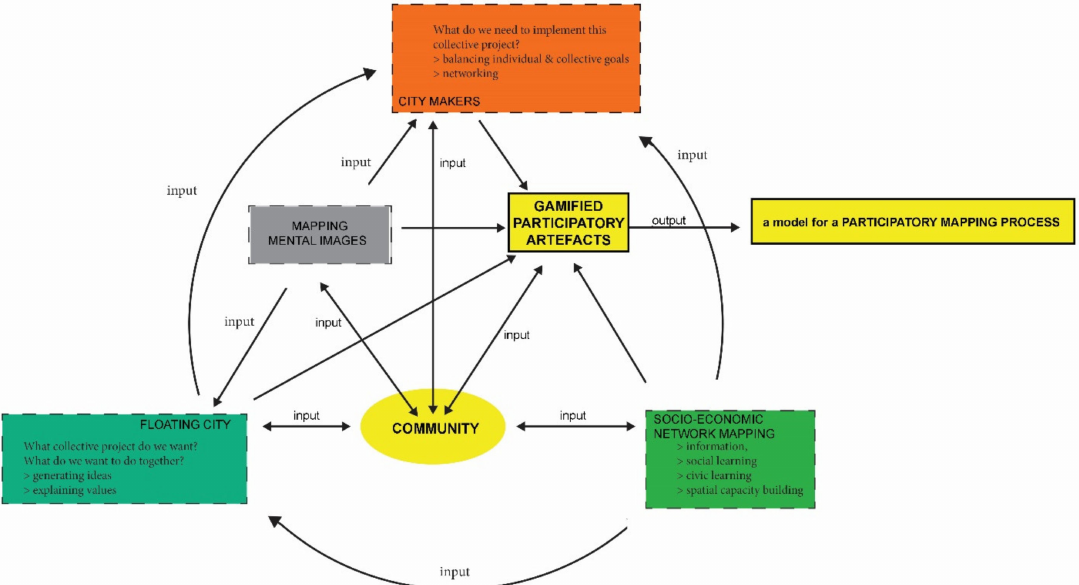
Figure 8. Dynamics of gamified participatory artefacts in a participatory mapping